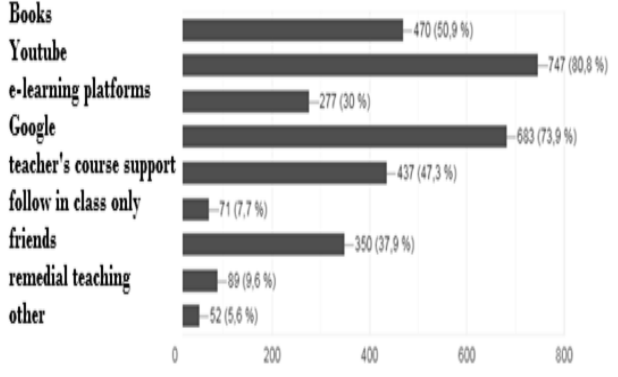
Fig. 3. Complementary learning tools and